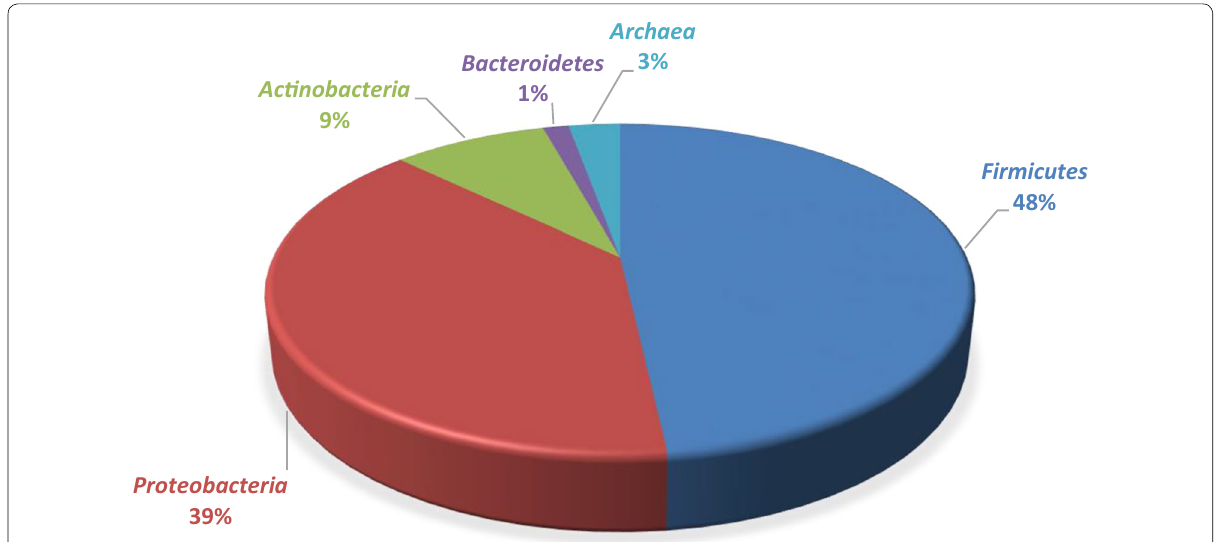
Fig. 1 Distribution of the relative abundance of the Bacteria and Archaea strains isolated at Zipaquirá salt